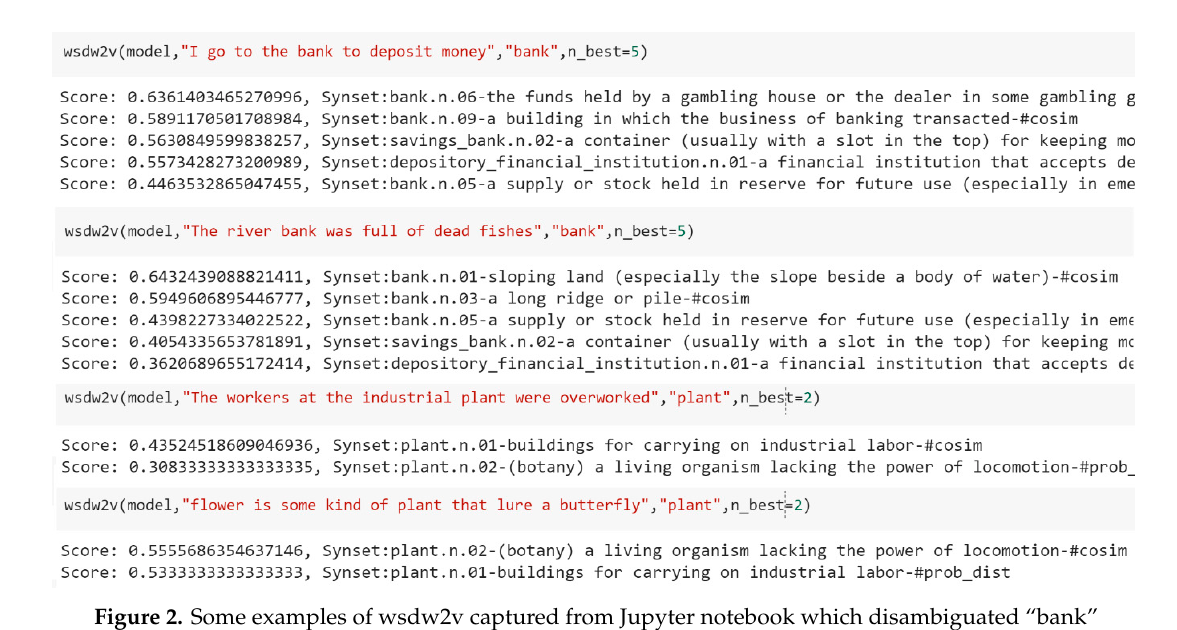
Figure 2. Some examples of wsdw2v captured from Jupyter notebook which disambiguated “bank” and “plant” in different contexts.